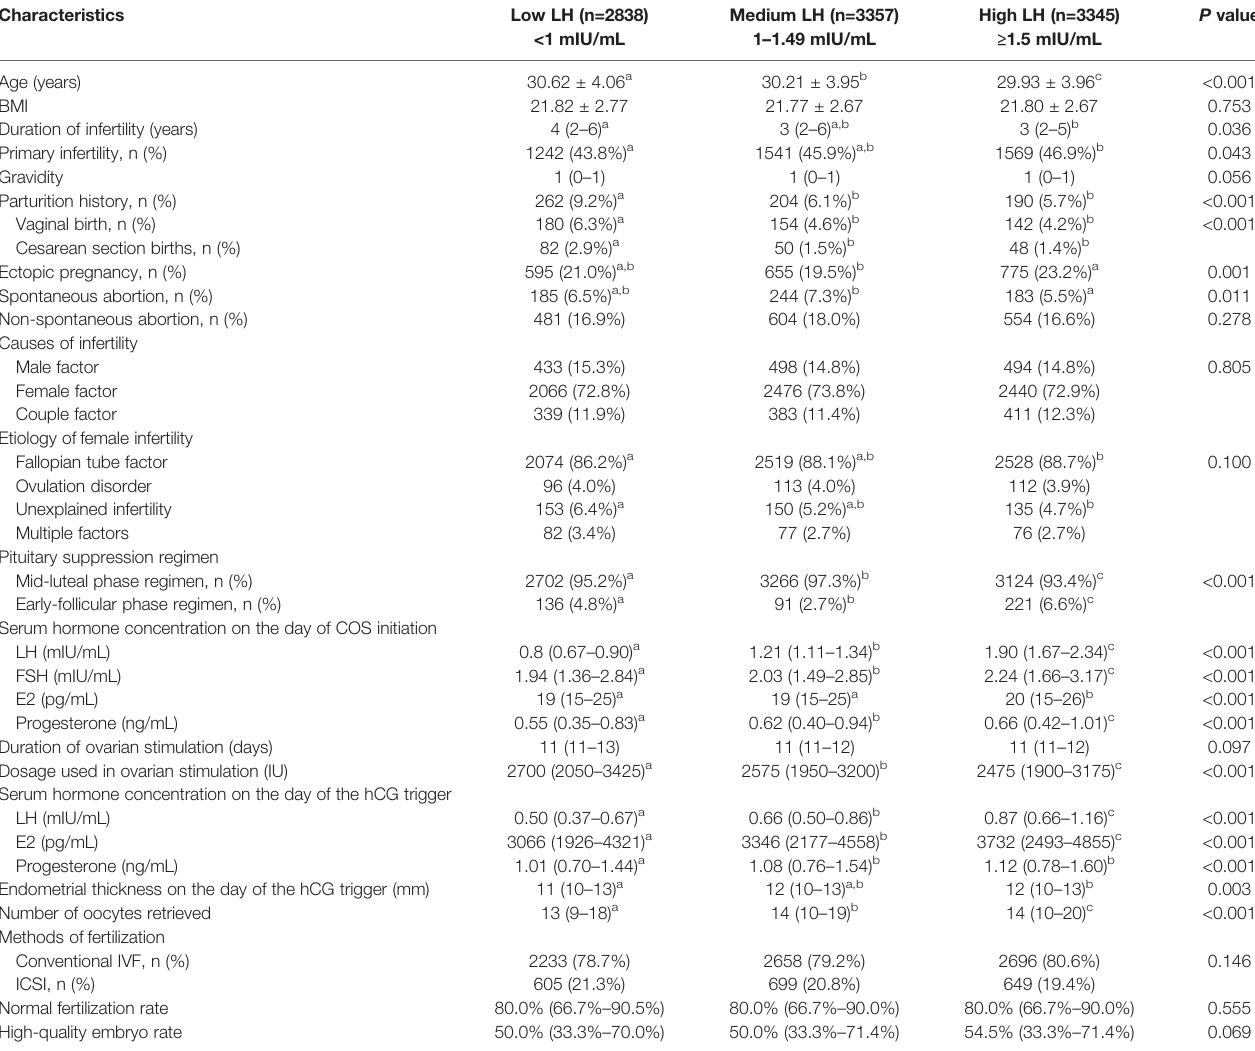
TABLE 1 | Baseline analysis of LH groups on the COS initiation